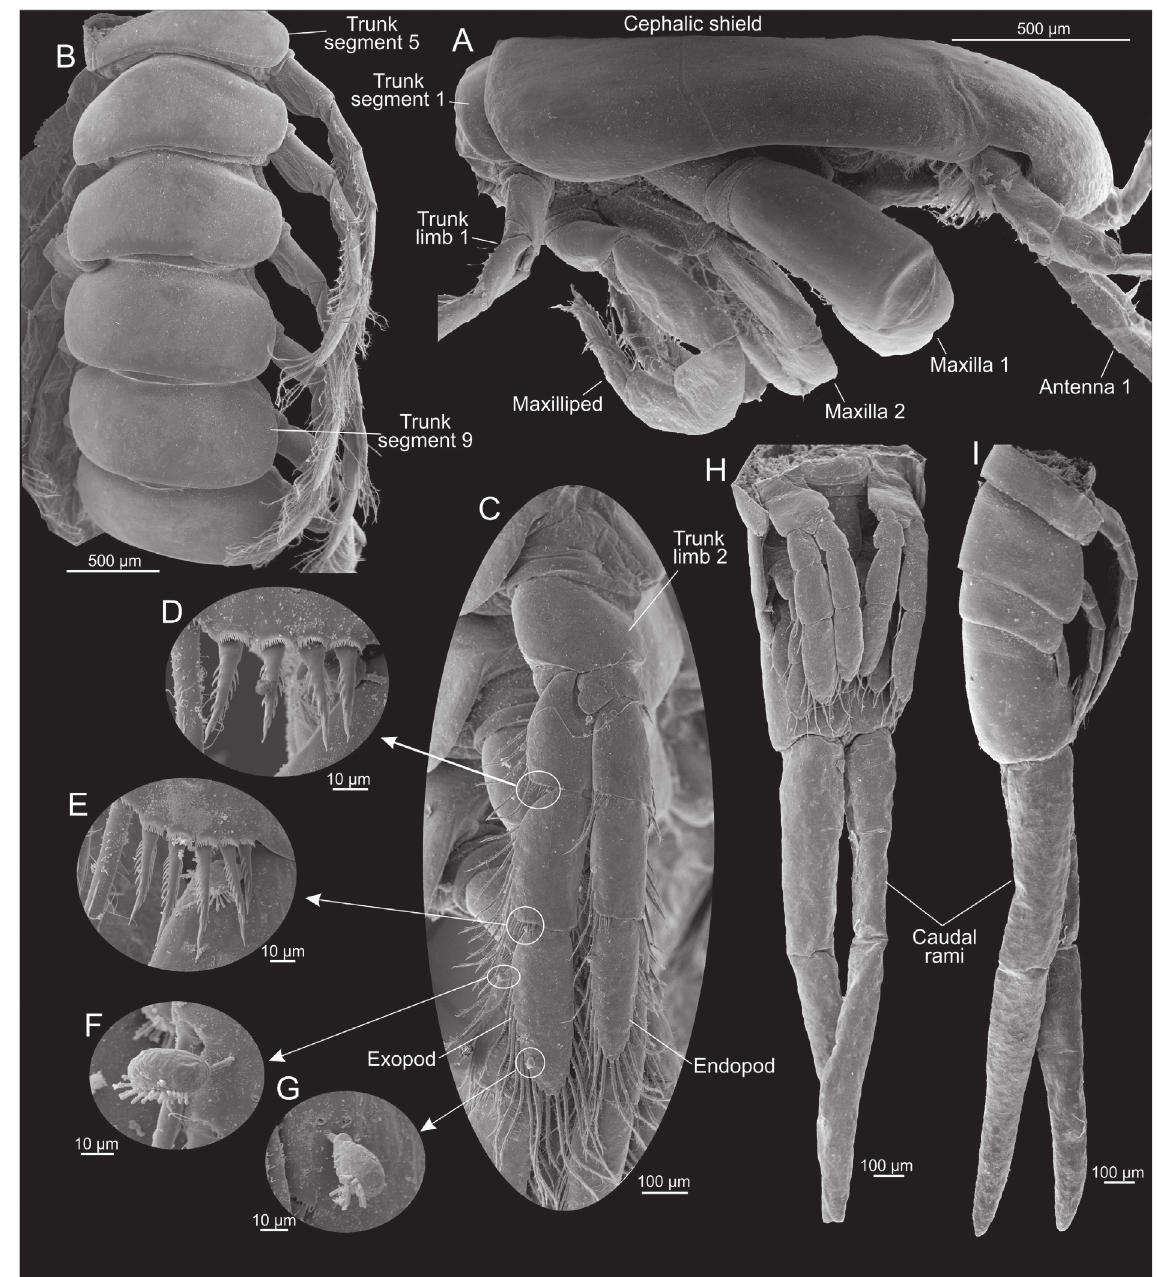
Fig. 10. Xibalbanus cozumelensis sp. nov., paratype (ZMUC-CRU-4792), cephalon, body segments, and trunk limbs, scanning electron microscopy. A . Cephalon, cephalic shield, and head appendages from lateral. B . Trunk segments 5–10. C . Trunk limb 2, right side. D . Close-up of serrated setae in latero-distal corner of exopod segment 1. E . Close-up of serrated setae in latero-distal corner of exopod segment 2. F–G . Two unidentified suctorians attached to exopod of trunk limb 3. H–I . Posterior body segments, trunk limbs, and caudal rami from ventral